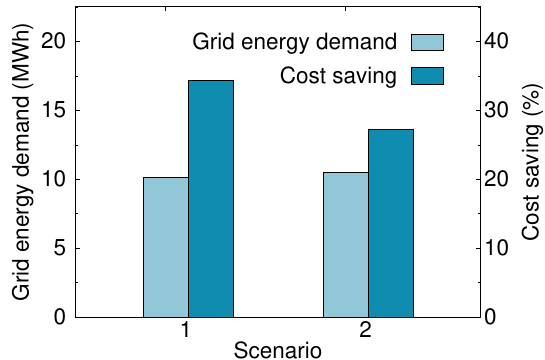
Figure 10. Cost-saving and total grid energy demand for the scenarios 1 and 2 reported in Table